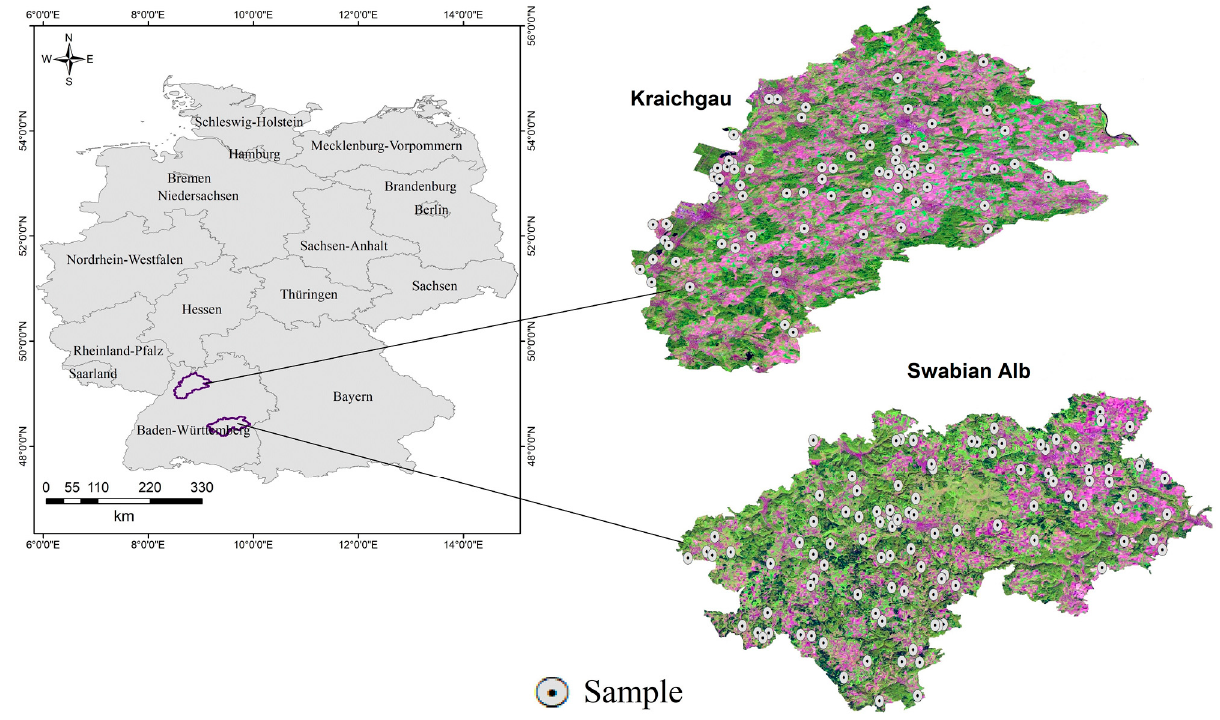
Figure 1. The geographic location of the two study areas (Kraichgau, K, and Swabian Alb, SA) in Southwest Germany and their spatial distribution of sampling points. Bulk soil samples were taken (0–30 cm) from agricultural